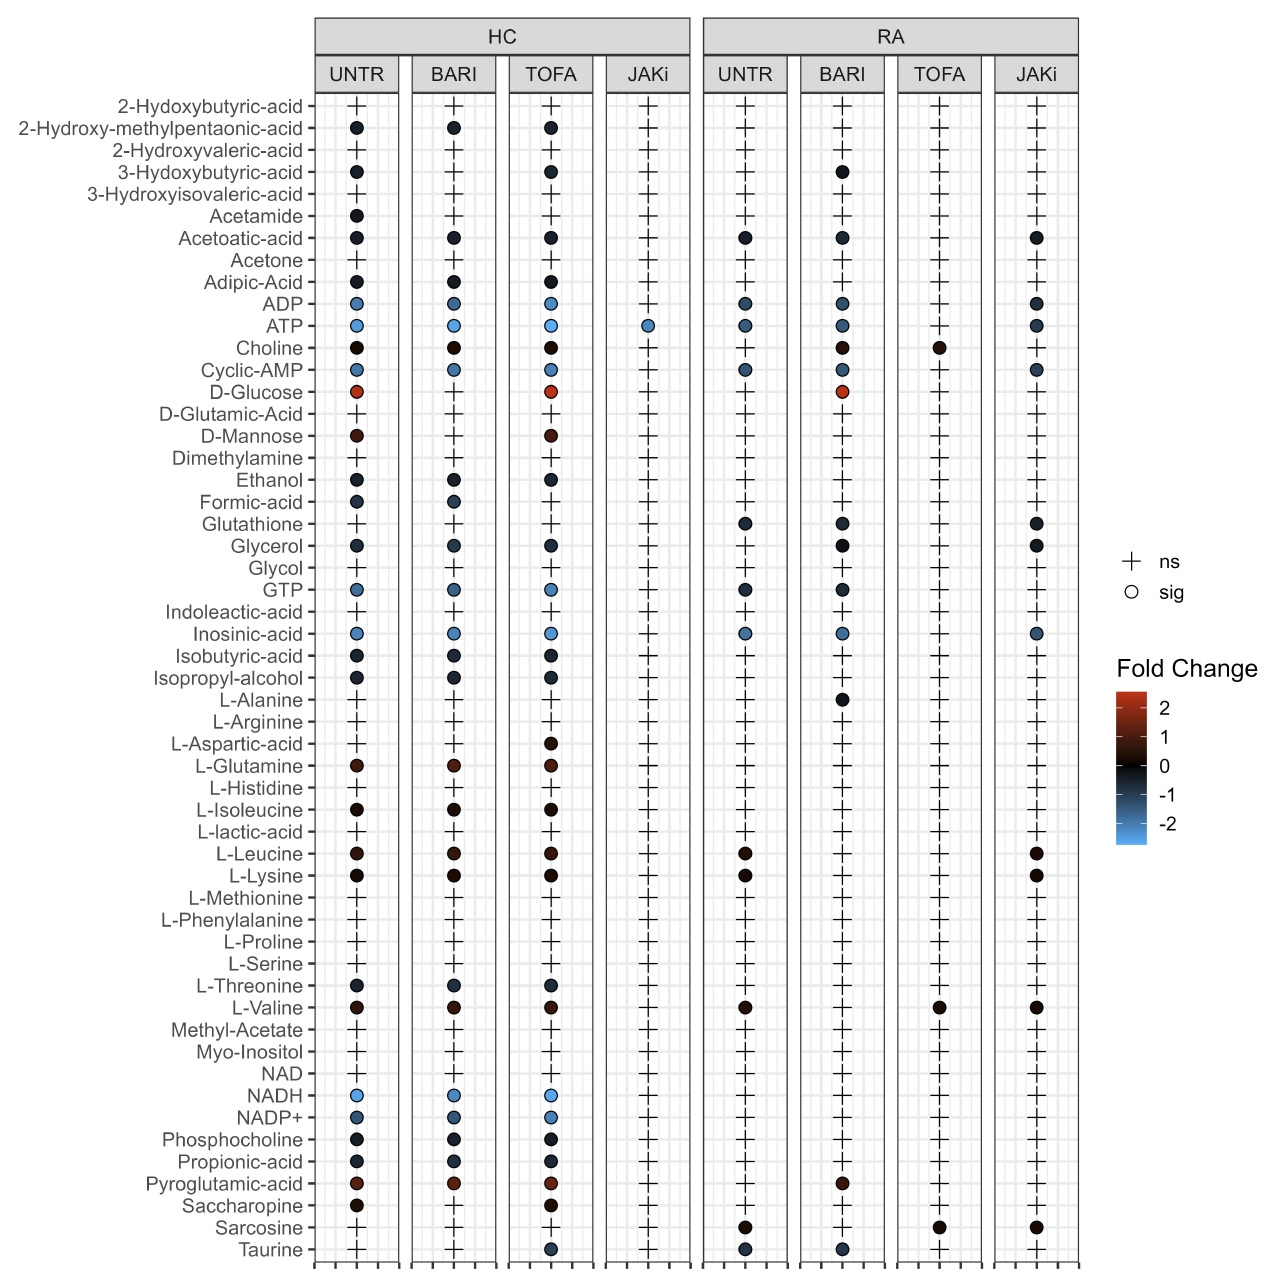
Figure 3. Univariate analysis comparing 0 h untreated HC and RA neutrophil metabolites with each 2 h treatment. (UNTR = Untreated, BARI = Baricitinib, TOFA = Tofacitinib, JAKi = Pan-Jak inhibitor). Metabolites which are significantly different between treatments are indicated by “•” and the log2 fold change (FC) against 0 h control for each metabolite is indicated by gradient colour scale